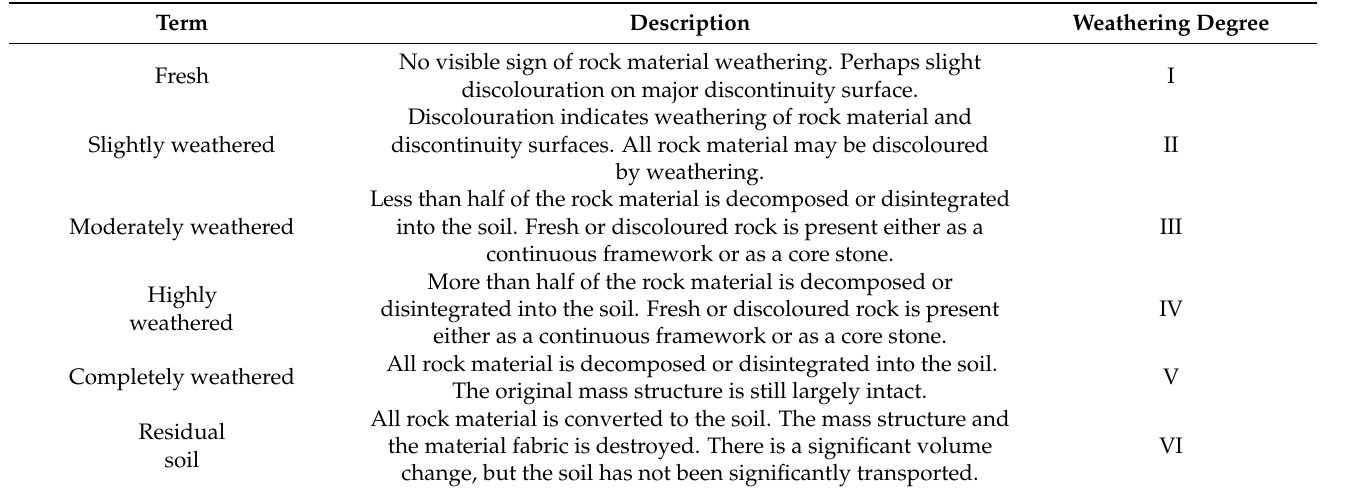
Table 3. Weathering degree based on ISMR [53].